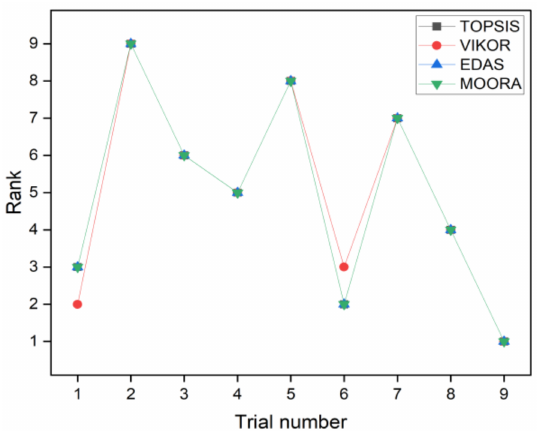
Figure 11. Comparison of ranking results for case study 2.